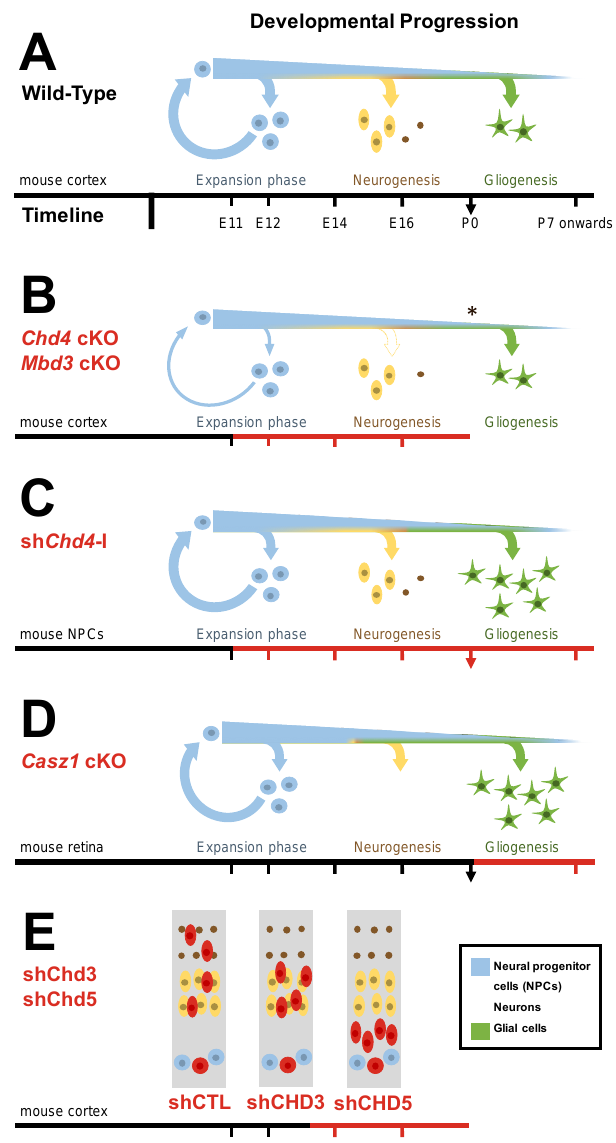
Figure 4. Effect of NuRD deficiency on neural lineages. Progenitors give rise to diverse neural populations in a temporally regulated manner. Selected examples illustrate how deficiencies in NuRD complex subunits impact on temporal development, potentially contributing to neurodevelopmental disorders. Red scale bars or cells indicate the genetically manipulated populations. ( A ) Wild-type. ( B ) In the Chd4 and Mbd3 conditional knockout neocortex, progenitors underproliferate, leading to reductions in upper layer neurons [13,77]. ( C ) Chd4 RNAi has also been linked to premature gliogenesis in neocortical cells, although this effect may be independent of NuRD [35]. ( D ) Casz1 conditional mutant retinal progenitors overproduce glia at the expense of rod photoreceptors in a NuRD-dependent fashion [34]. ( E ) In neocortical cells, Chd3/5 RNAi disrupts neuronal migration at distinct phases [13]. Asterisk indicates lethality prior to postnatal